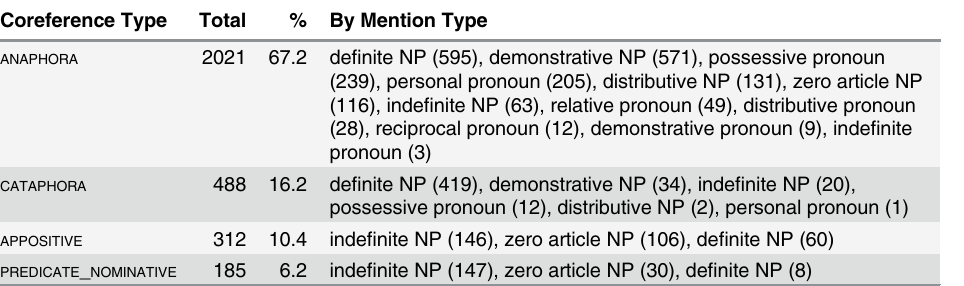
Table 4. After fine-grained annotation.